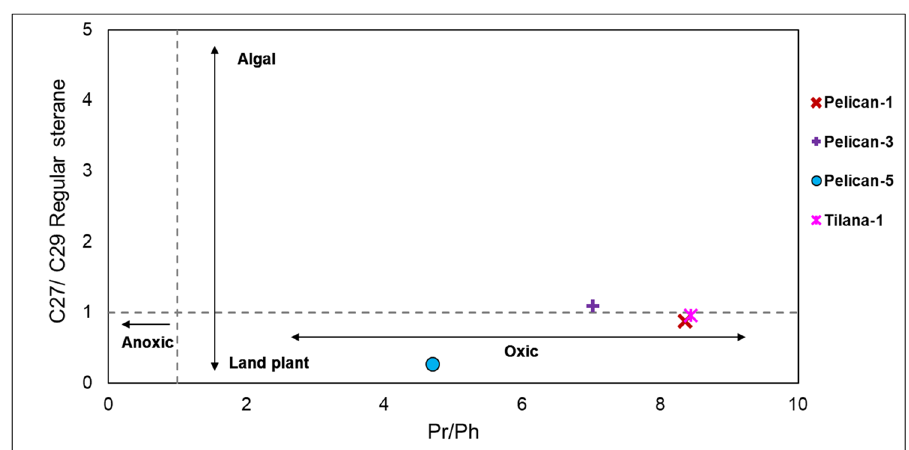
Fig. 17 Further support for paleodepositional environment by plot of C 27 /C 29 regular ster- ane versus